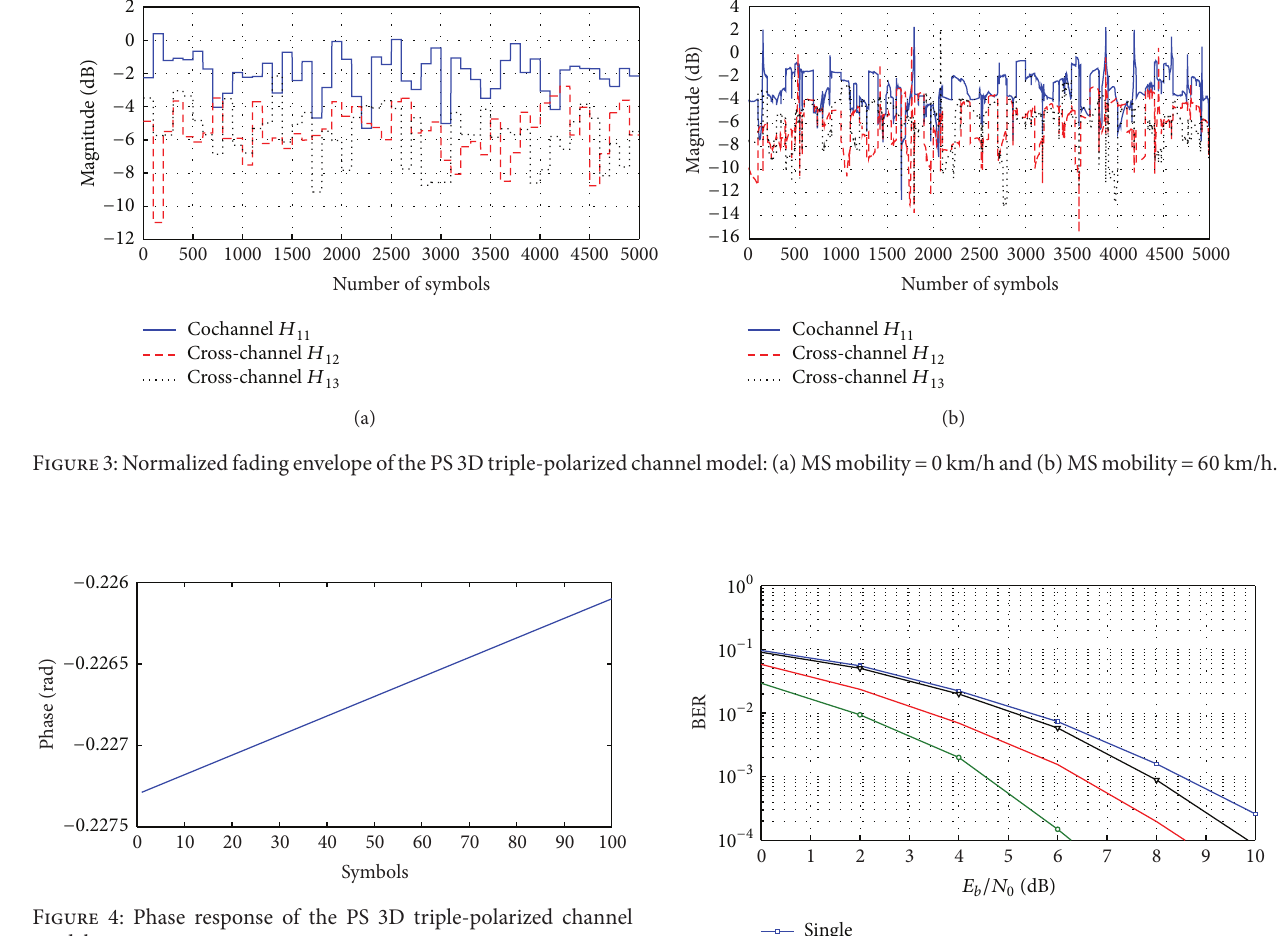
Figure 4: Phase response of the PS 3D triple-polarized channel model.